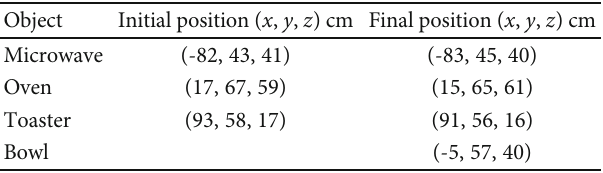
Table 2: Spatial position of the detected objects in the kitchen coordinate